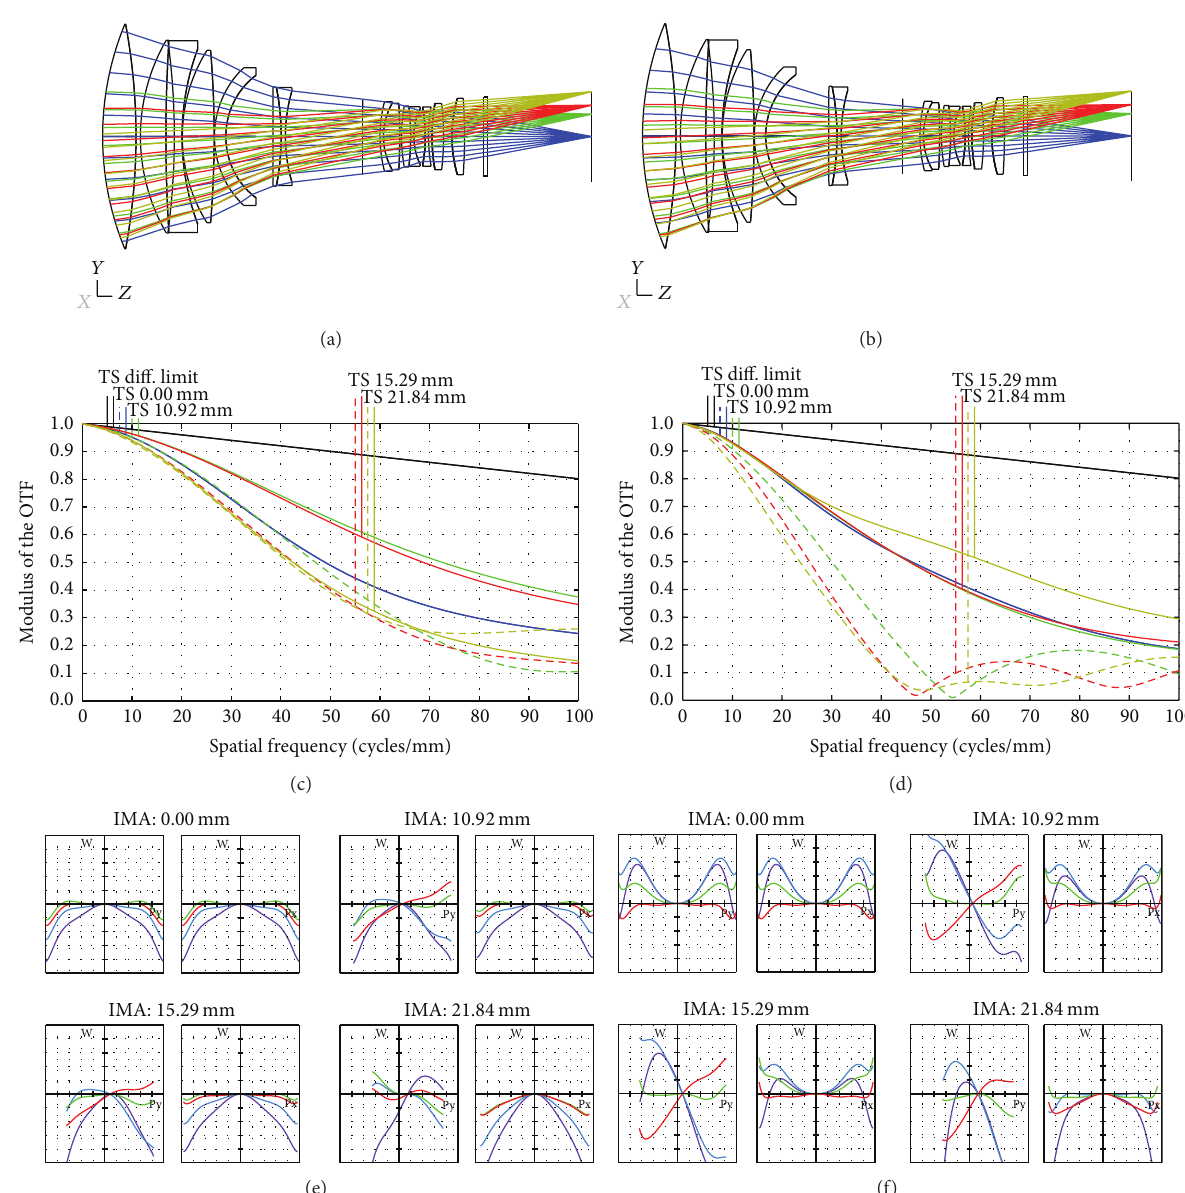
Figure 5: Canon telephoto lens original patent data for infinite ((a), (c), and (e)) and 2-meter ((b), (d), and (f)) object distance configurations. OPD fan scale is 2